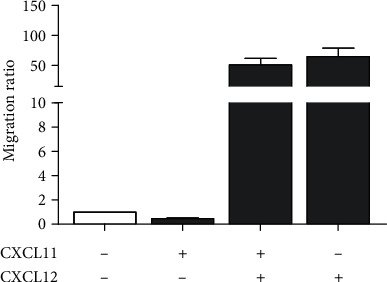
Cooperative effect of CXCL11 and CXCL12 on the migratory ability of CLL cells. CLL cells (n = 6), with/without pretreatment with 200 ng/mL CXCL11, were added to the upper chamber of Transwell inserts. 200 ng/mL CXCL12 was added to the medium in the bottom chamber, and migrated cells were counted after 3 hours by flow cytometry. Migration index was calculated as the ratio of cells that transmigrated through the insert in the chemokine-treated cells vs untreated ones (CXCR11-/CXCR12-).